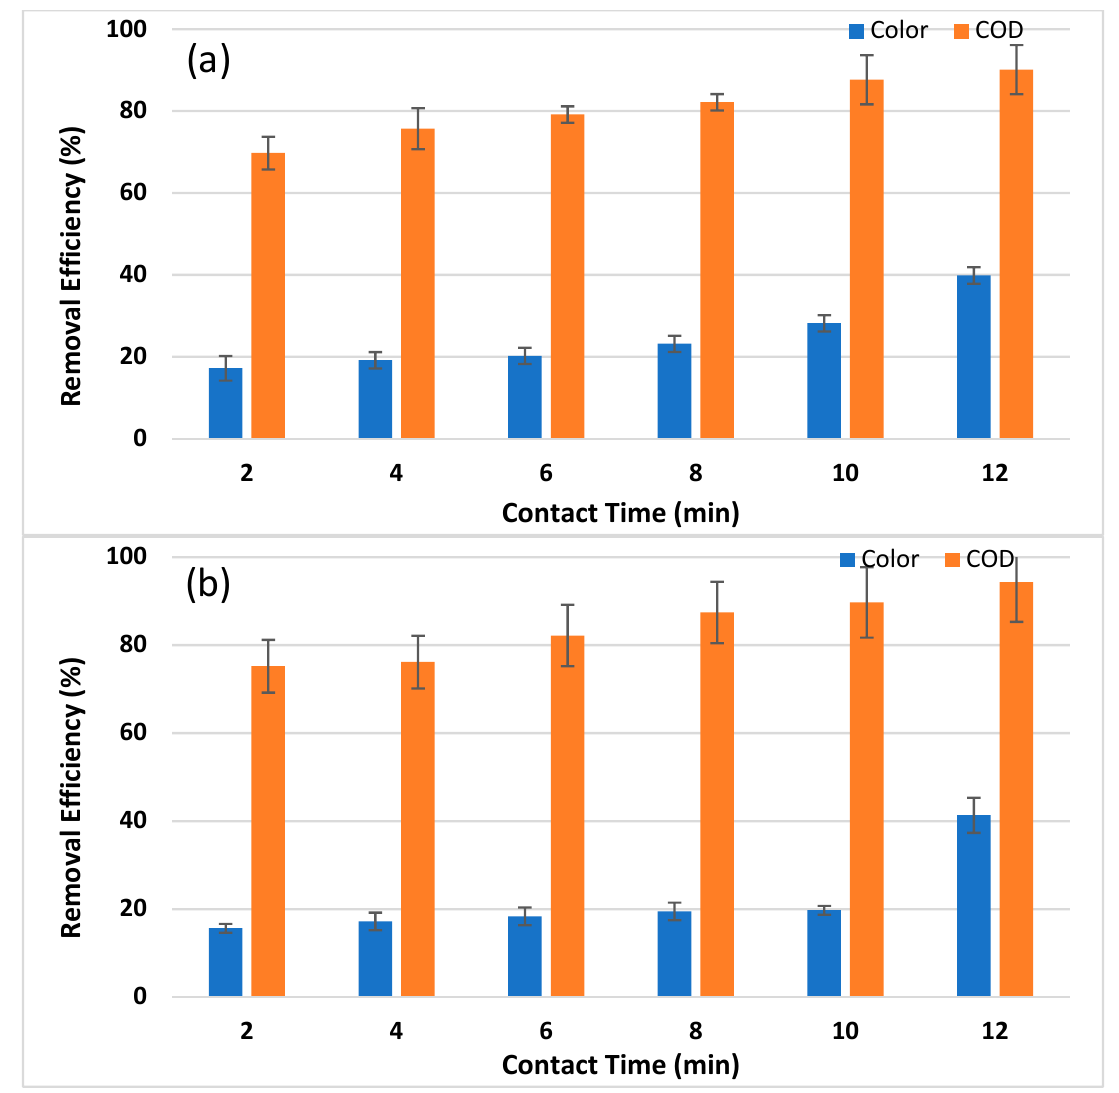
Figure 9. ( a ) Photo-Fenton treatment of raw pulp and paper wastewater and its removal efficiency for color and COD at different contact times of 2, 4, 6, 8, 10 and 12 min. ( b ) Photo-Fenton treatment of biologically treated pulp and paper wastewater and its removal efficiency for color and COD at different contact times of 2, 4, 6, 8, 10 and 12 min. Means values are presented with standard deviation. The results showed that the ozone treatment had the highest efficiency, with efficiencies of 41.22% and 88.53% for color and COD removal, respectively. The photo-Fenton technique produced good results, with removal efficiencies of 39.83% for color and 90.13% for COD. Its efficiency for COD removal was somewhat greater than that of the ozone treatment, but when contact time was considered, the ozone treatment produced the best results in the shortest contact time. Another crucial consideration is the generation of sludge, which is low in the ozone treatment. Other treatments, such as the biological and chemical treatments, demonstrated poor efficiency for these parameters. Aside from the chemical and biological treatments, removal efficiencies of 26.30% for color and 86.33% for COD using Fenton oxidation, and 28.45% for color and 85.13% for COD using the hydrogen peroxide treatment, were achieved. Ozone treatment is expensive, and Fenton treatment generates sludge that is difficult to